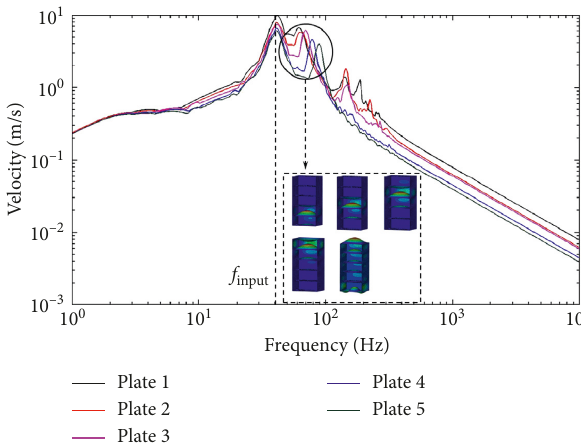
Figure 13: Shock spectrums of five plates when frequency of loads is 40Hz.